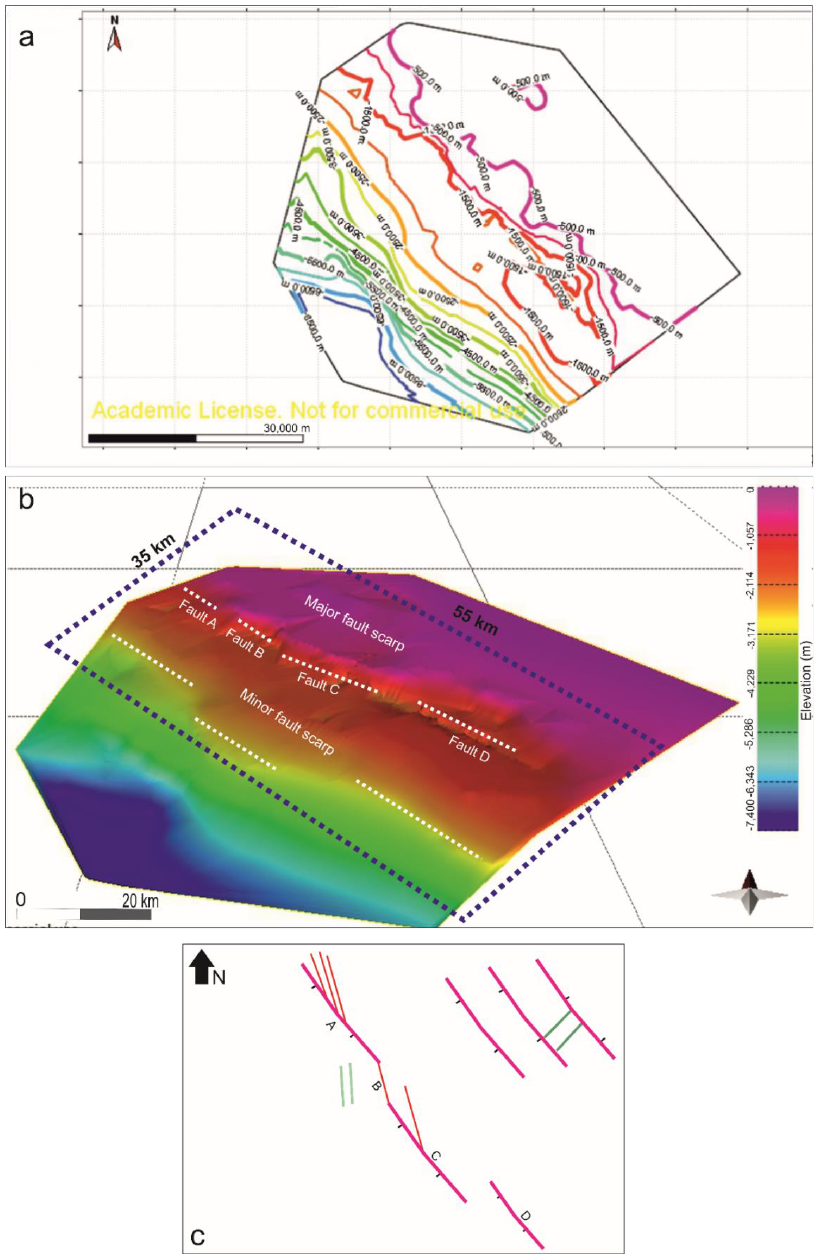
Figure 5. ( a ) Two-dimensional isobath map of Apulian Carbonates Platform. The isobath (every 500 m) are referred to the Apula top surface (Upper Cretaceous to Messinian age); ( b ) three-dimensional view of the top Apula surface, showing the architecture of the major fault scarp obtained by 3D modeling. The legend bar to the right shows with different colors the surface elevation in meters. The dashed blue line represents the investigated area. The isobath map was obtained after interpretation of 2D seismic reflection profiles, well log data, and by considering the isobath map by Nicolai and Gambini [78]); ( c ) present-day fault architecture shown in plan view. Traces of minor fault segments are also shown. The traces of the main fault segments are reported in magenta, red and green lines represent the traces of subsidiary high-angle faults.